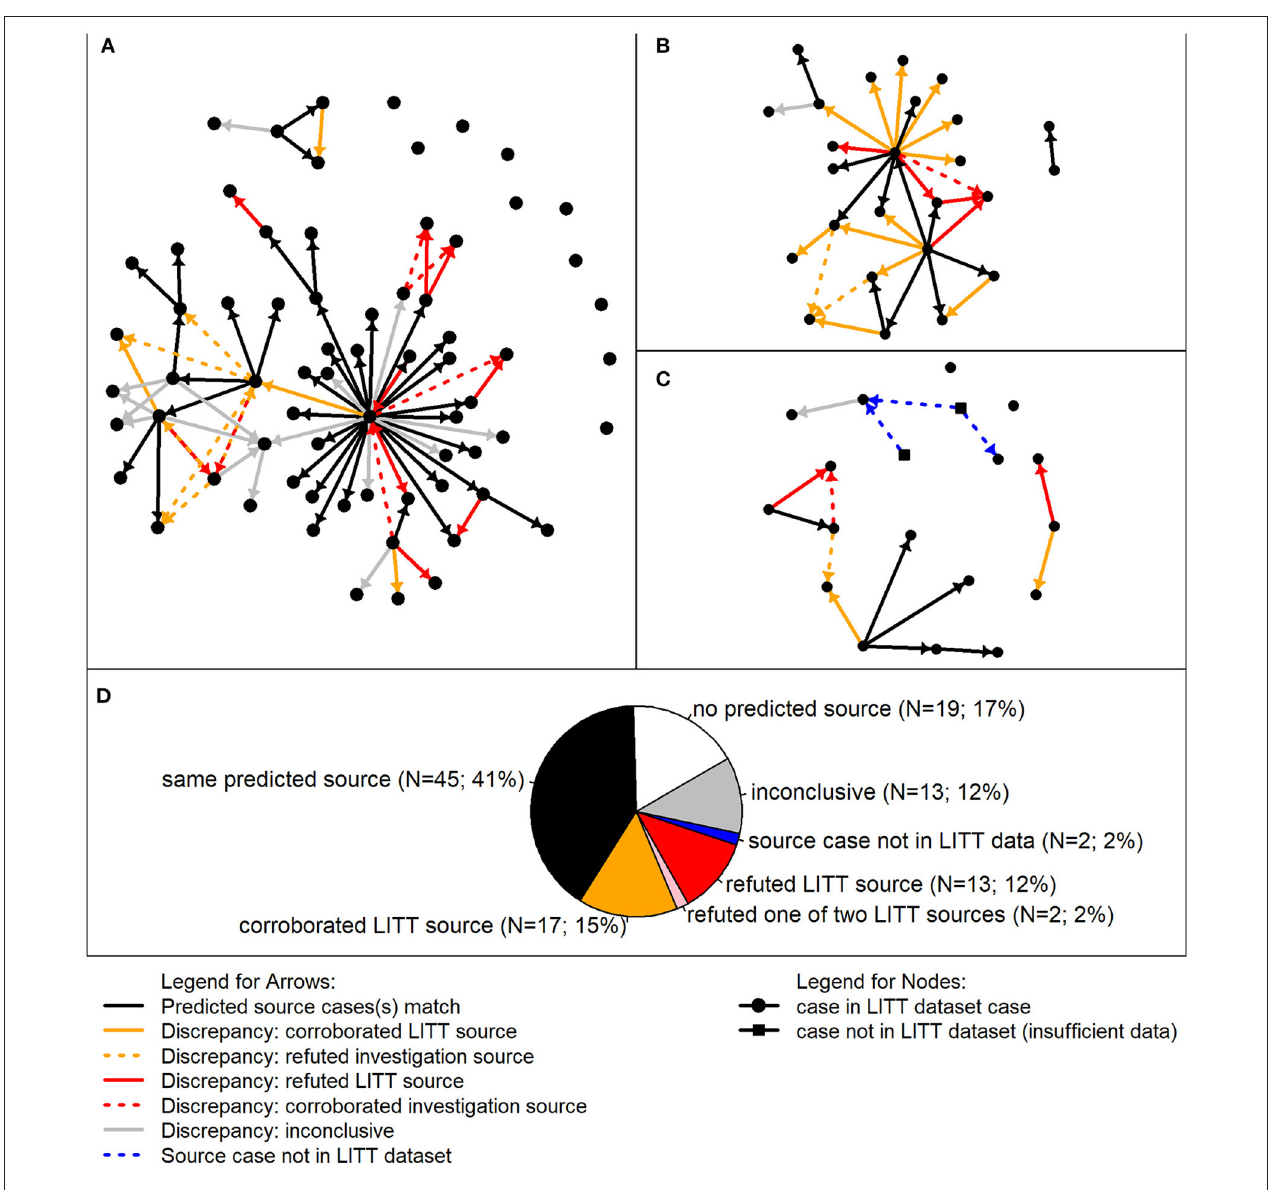
FIGURE 4 | Detailed review of most likely TB source cases predicted by the Logically Inferred Tuberculosis Transmission (LITT) algorithm vs. presumed sources identified by local investigation. In the analysis of discrepancies, 111 given cases associated with three clusters were included. Presumed source cases of Mycobacterium tuberculosis transmission were identified by public health investigations conducted by the California Department of Public Health and their partners. (A–C) Transmission networks for three TB clusters. Each circle represents a case in the LITT dataset; squares indicate cases not in the LITT dataset (i.e., insufficient data on disease timing and clinical characteristics). Arrows point from a source case identified by LITT and/or the investigation to a given case. Solid arrows point from the most likely source predicted by LITT to the given case. Black solid arrows indicate that the source case was also determined to be the most likely by the investigation. Dashed arrows indicate the source case was determined to be the most likely by the investigation, but not by LITT. A detailed review was performed when the most likely source case predicted by LITT was different than the presumed source case determined by the investigation (i.e., all arrows except the black arrows). The arrows are colored by detailed review results. Gold: review corroborated LITT or refuted the investigation in favor of LITT; red: review refuted the most likely LITT source or corroborated the investigation source over LITT; and gray: inconclusive detailed review (i.e., insufficient data to corroborate or refute). Blue dashed lines indicate possible connections from cases not in the LITT dataset. (D) Aggregate summary of detailed review findings combining cases from the three clusters. Relative numbers of given cases in each category are included by the same color code (see legend). In other words, the color of the arrows (solid or dashed in (A–C) going in to the given case corresponds where that given case was counted in the pie chart, with the exception of the pink wedge, which corresponds to given cases having two LITT potential sources, one of which was refuted (red) and the other was identified by the investigation (black).